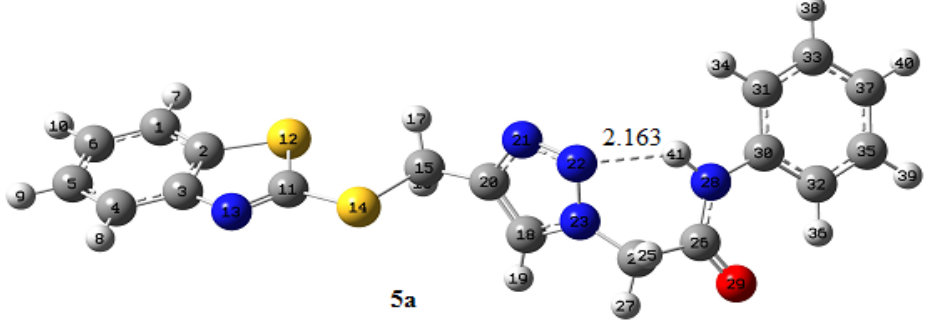
Figure 3. The B3LYP/6-31 + G(d, p ) optimized geometry of 5a (distance in Å).